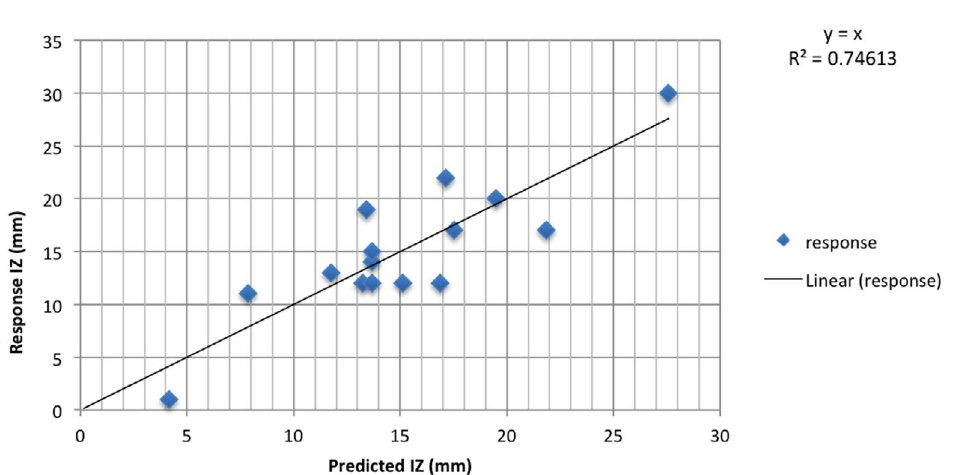
Fig. 5. Residual diagnostics of quadratic model surface: The predicted response versus observed antimicrobial activity of Aspergillus terreus SHE05.